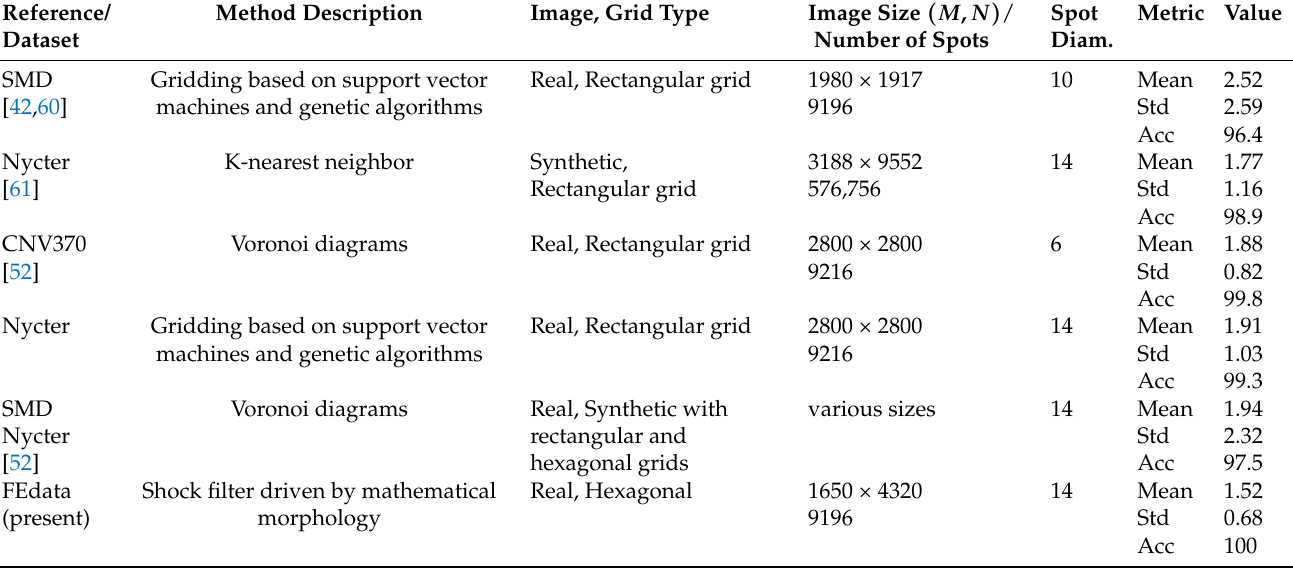
Table 2. Results of the proposed grid alignment methodology: means and standard deviations of distances between annotated and detected centers, and